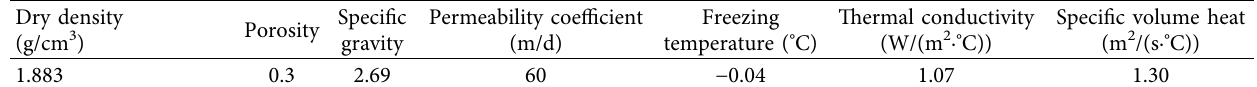
Figure 1: Particle size distribution of gravel Table 1: Physical and thermal properties of gravel soil.